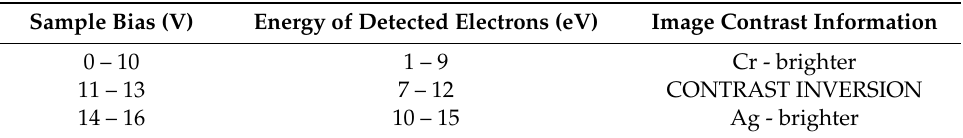
Table 3. The simulated band-pass filter properties for Ag / Cr sample.